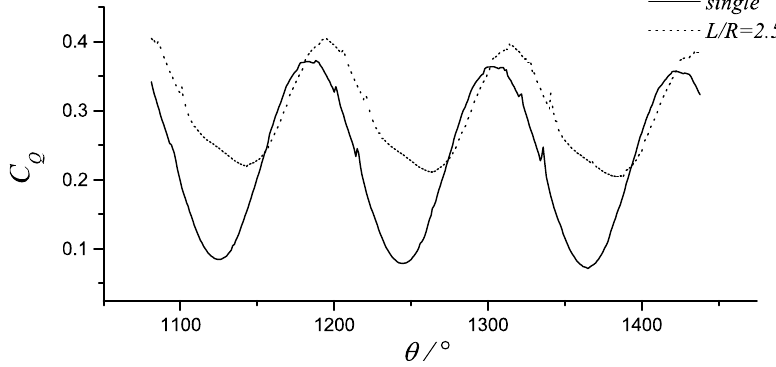
Figure 11. The comparison of the turbine torque coefficient in the parallel and single situation where Z = 3.